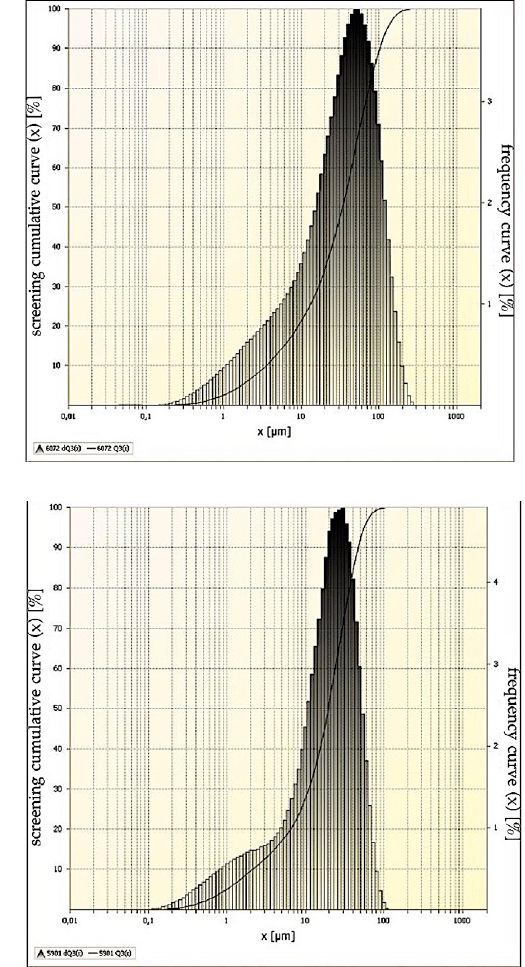
Figure 2. Example of the distribution of three types of copper ore comminuted in a hydro-jet mill at a water pressure of 150 MPa: ( a )—carbonate, ( b )—sandstone, ( c )—shale ore, performed using the Analysette 22 MicroTec Plus particle laser meter.